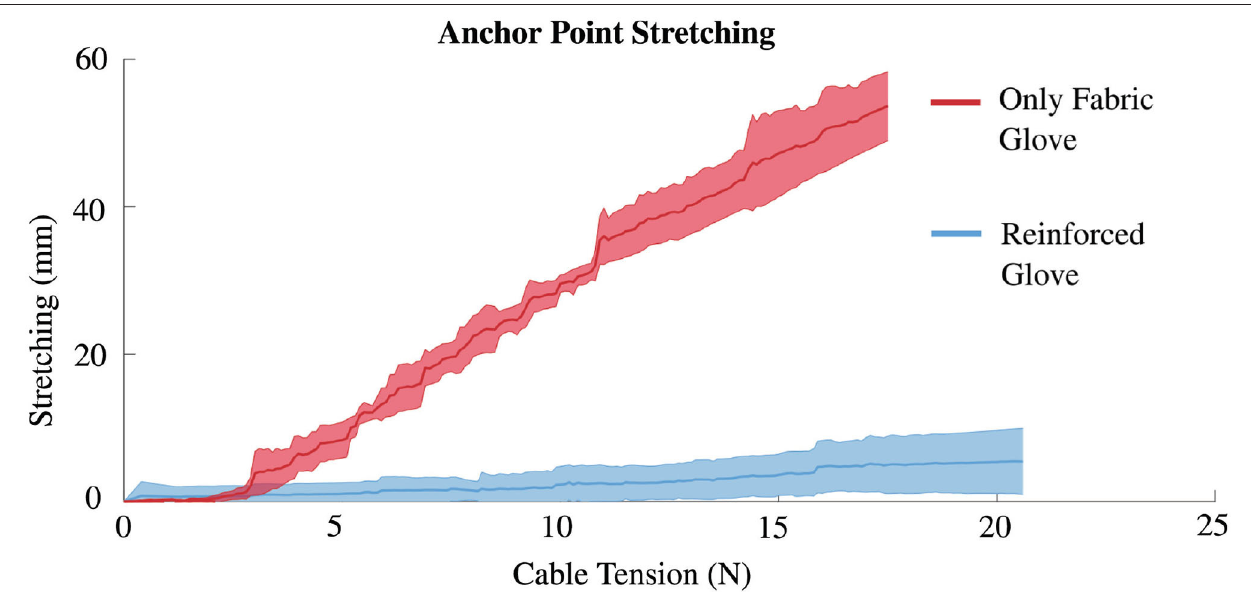
FIGURE 7 | Ergonomics evaluation: The plot reports the stretching of the glove—averaged over subjects and trials—when no reinforcement was sewn (in red) and when the three-dimensional (3D)-printed plastic modules were sewn (in light blue). Without reinforcement, the transmission exhibited a stiffness of 0.296 N/mm and the anchor point shifted of more than 50 mm under a load of 17.5 N, thus causing discomfort due to fabric over stretch. In this case, it was not possible to continue with higher loads due to reaching of maximum contraction of the transmission cable. Reinforced glove solution exhibited a stiffness of 3.33 N/mm that was sufficient to comfortably transfer loads up to 50